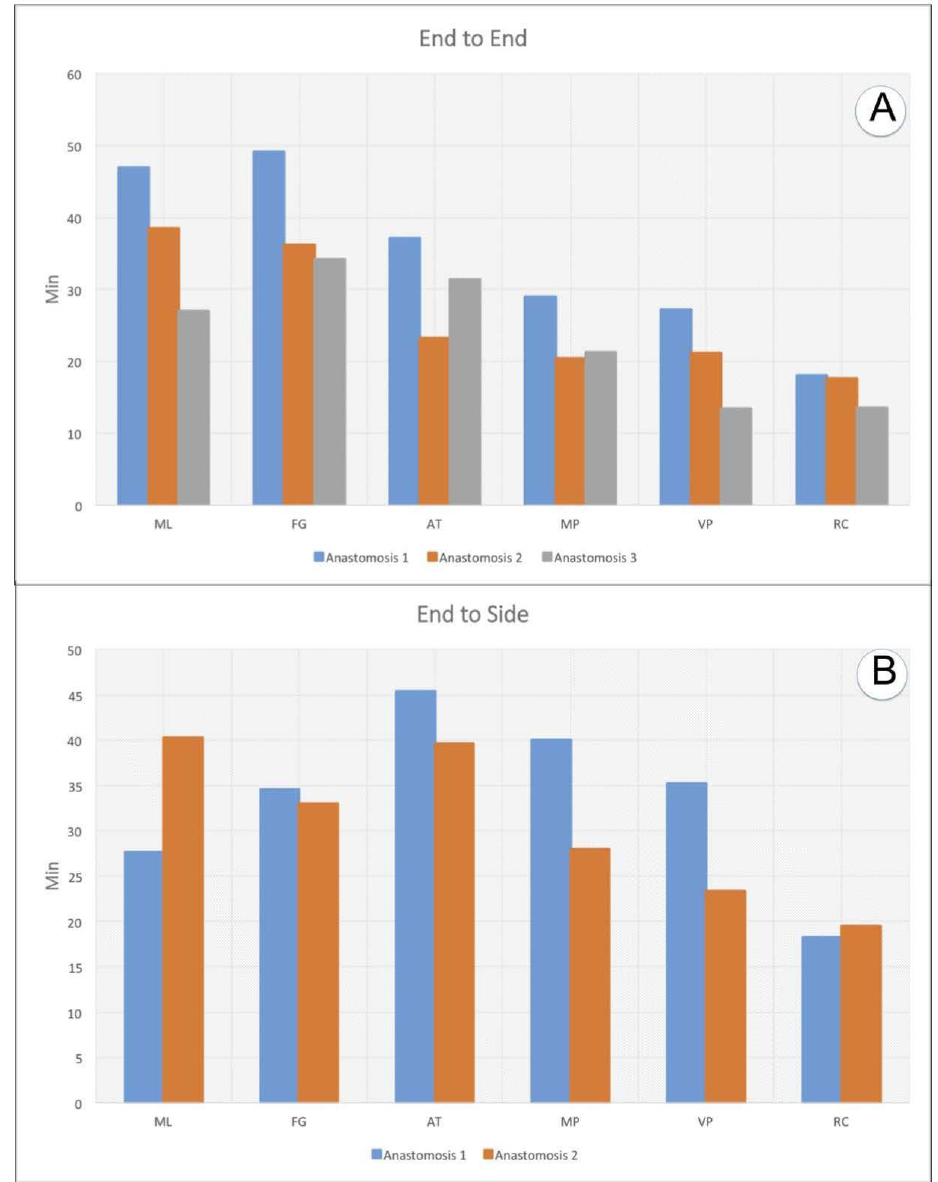
Figure 5. Charts showing the improvement of surgical performance with practice: ( A ). Time spent by each surgeon to complete the three end-to-end anastomoses and ( B ) Time spent to complete the two end-to-side anastomoses.